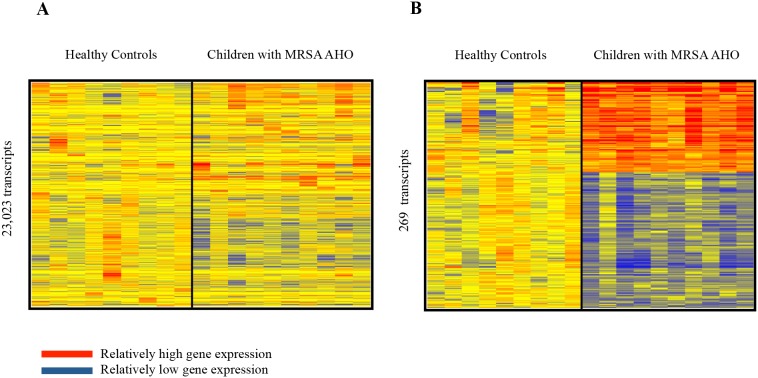
Gene Expression Biosignature in Whole Blood From Healthy Controls and Patients With MRSA AHO.Statistical tests were used to compare the two study groups (Welch’s t-test, p<0.05 with Benjamini-Hochberg’s method). A) Analysis of the healthy control group with 9 subjects and the MRSA AHO group with 10 patients yielded 23,023 genes expressed at statistically different levels. Hierarchical clustering, used to organize those genes to reveal differential expression, supports that patients with MRSA AHO have unique signatures that classify them as different from controls. B) Further statistical analysis between the healthy controls and the MRSA AHO group yielded 269 genes expressed at different levels.